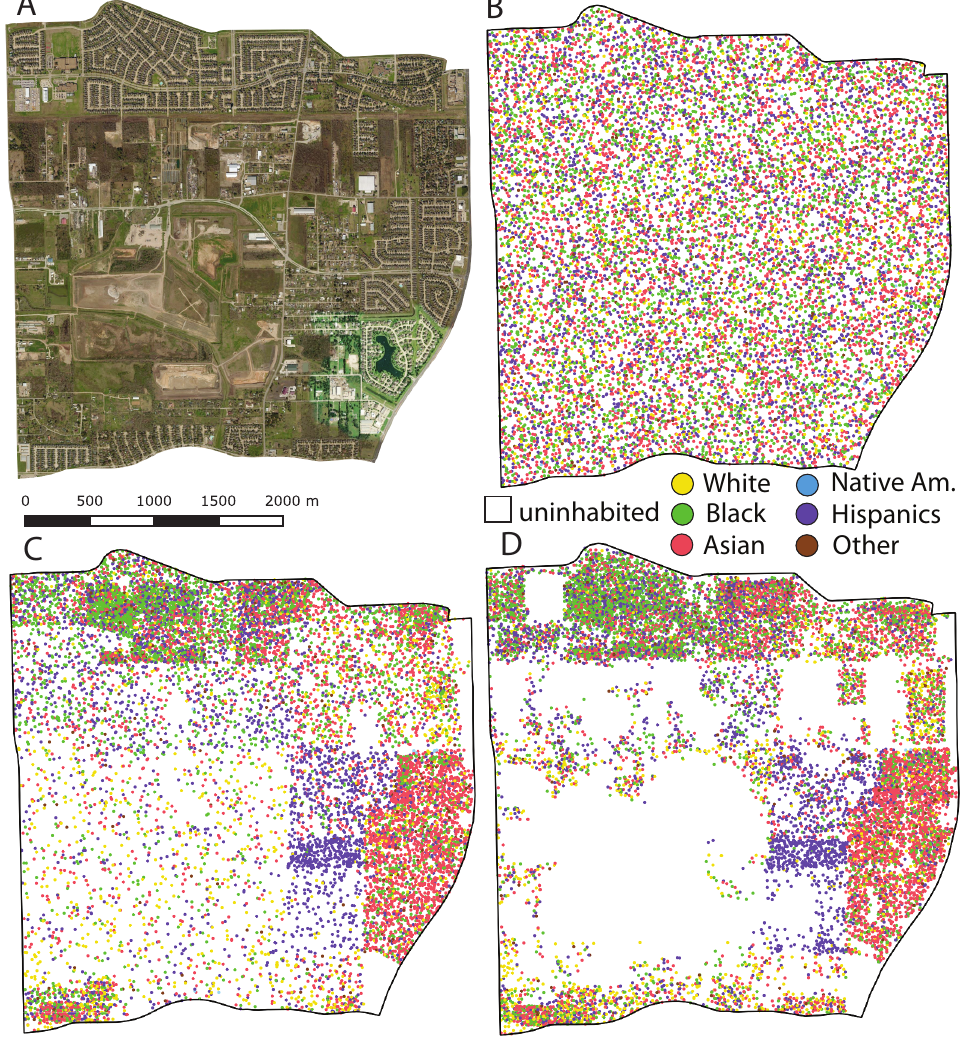
Figure 3. Comparison of racial dot maps of Census Tract Number 6727.01 in Sugar Land, Fort Bend County, TX, using different areal units. ( A ) An aerial image of the tract shows the distribution of inhabited and uninhabited areas; ( B ) dot map based on the Census tract; ( C ) dot map based on Census blocks; ( D ) dot maps based on grid